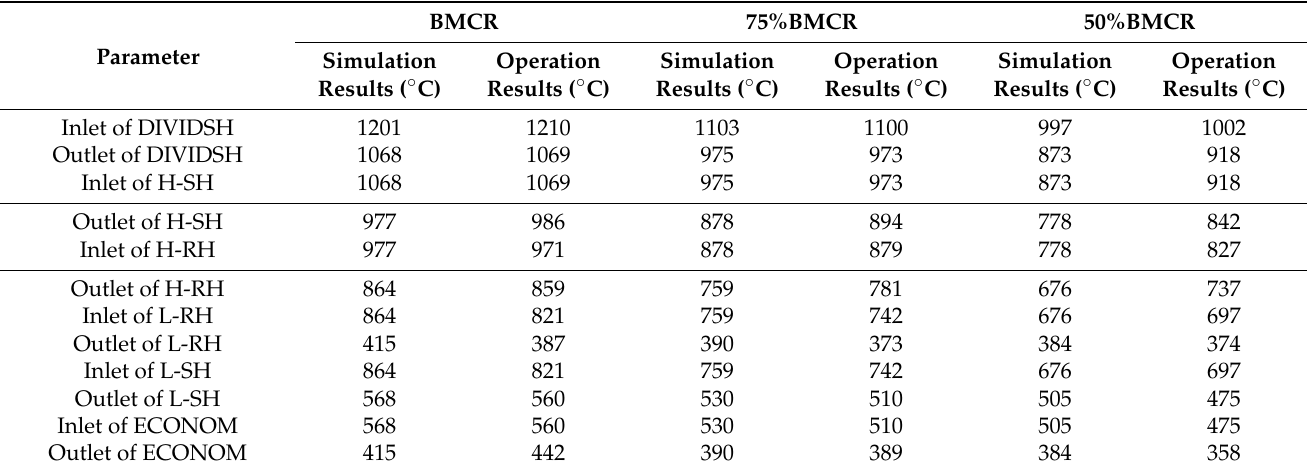
Table 7. Comparison table of flue gas simulation calculation results.